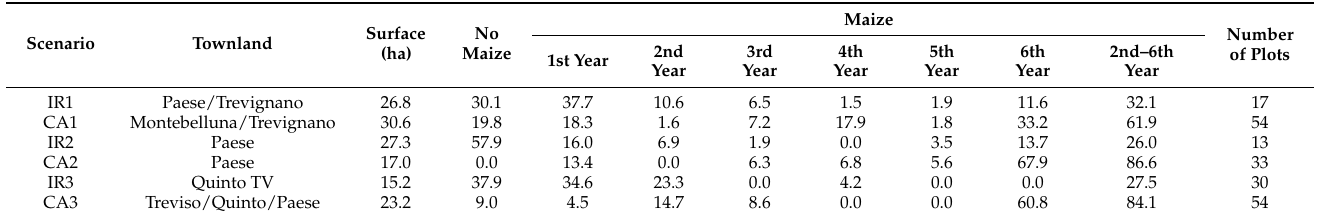
Table 3. Distribution of the rates of cultivated surfaces based on the number of consecutive years of maize cultivation in each rotation scenario under study, province of